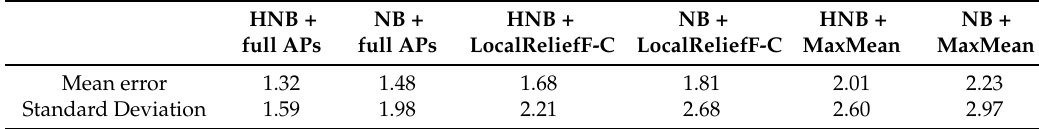
Table 7. Mean error distance and standard deviation of the four systems.